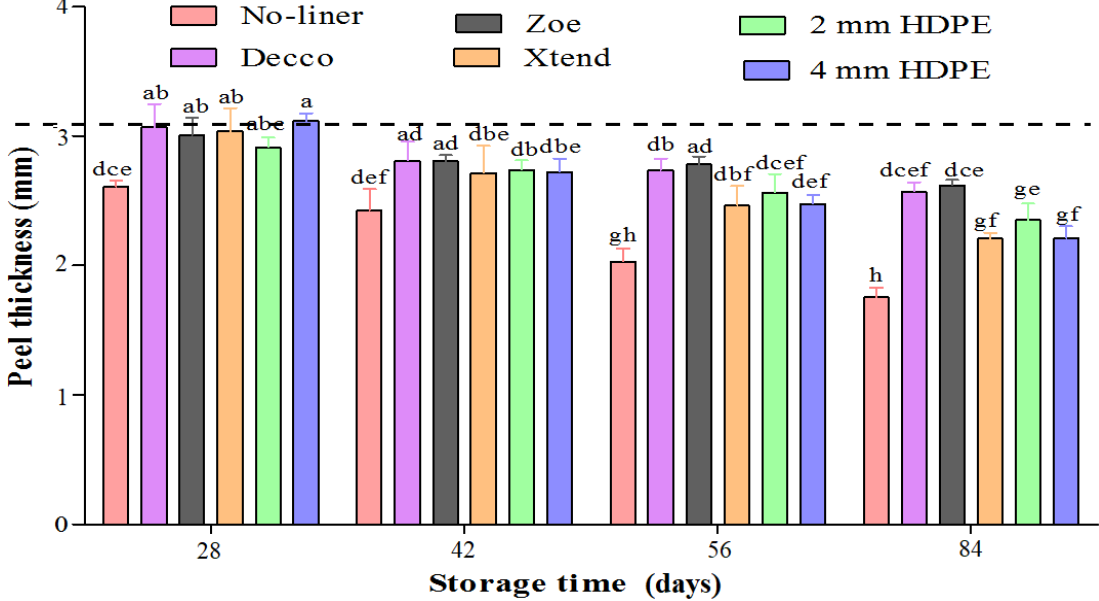
Figure 9. Peel thickness of pomegranate (cv. Wonderful) fruit stored at 5 °C and 90% relative humidity (RH). Mean values (vertical bars) with different letters are significantly different ( p <0.05) according to Duncan’s multiple range test. HDPE: high density polyethylene.